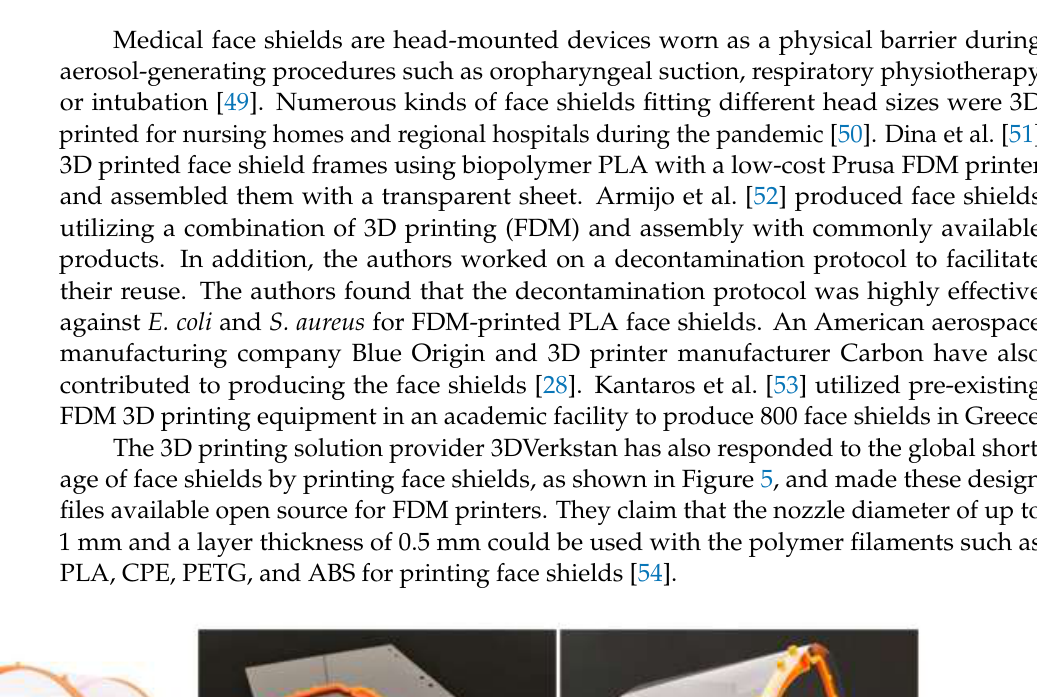
Figure 6. SLA-printed 3D Systems face shield by 3D Systems [56].